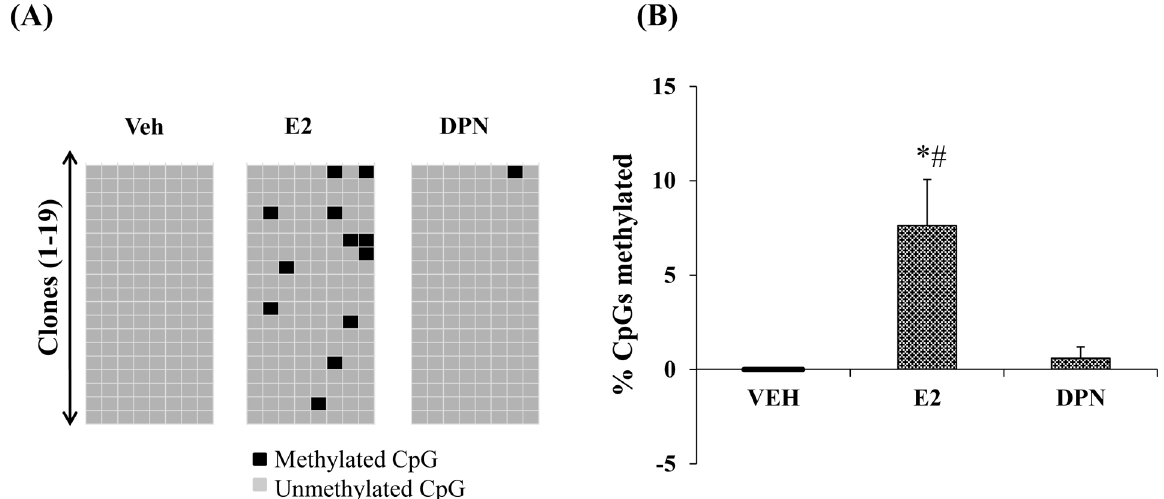
Fig 6. E2 increases the overall methylation of the cox-2 proximal promoter. A, Raw methylation data; each row is an independent clone and each column is one of eight CpG sites in the CpG island. B, Percent CpG island methylation (n = 3). Data represents mean ± SEM. ( * ) p = 0.035 E2 compared to VEH, (#) p = 0.049 E2 compared to